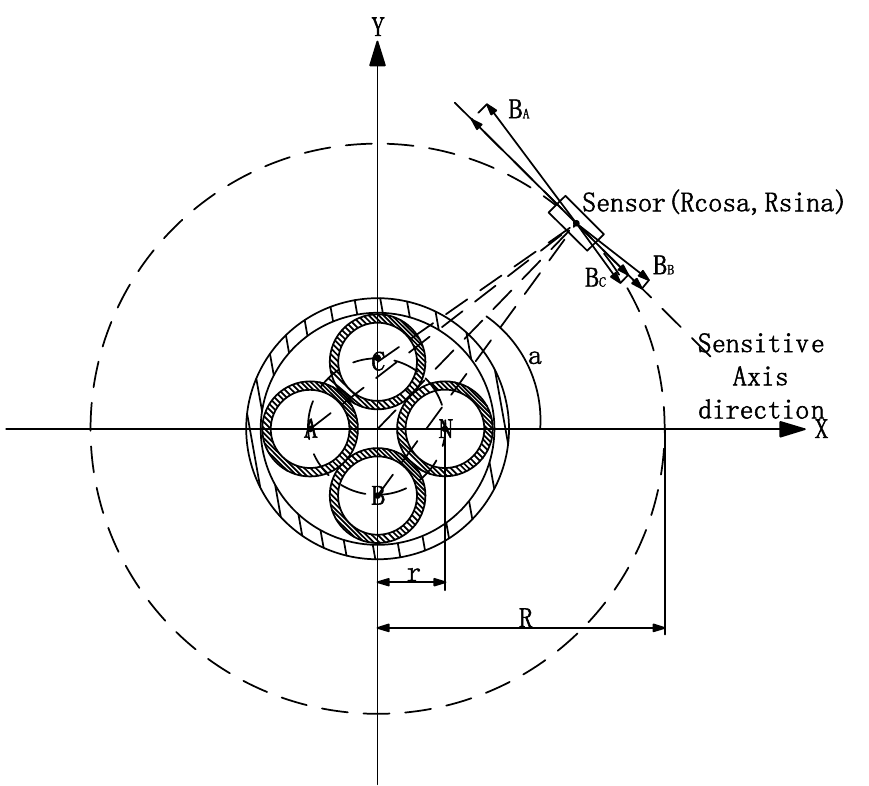
Figure 2. Diagram of the component of the magnetic field strength in the direction of the sensor’s sensitivity axis at a given moment.